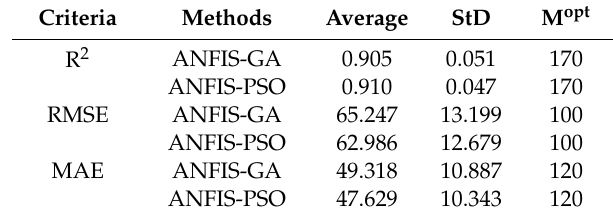
Table 4. Summary information of robustness analysis.